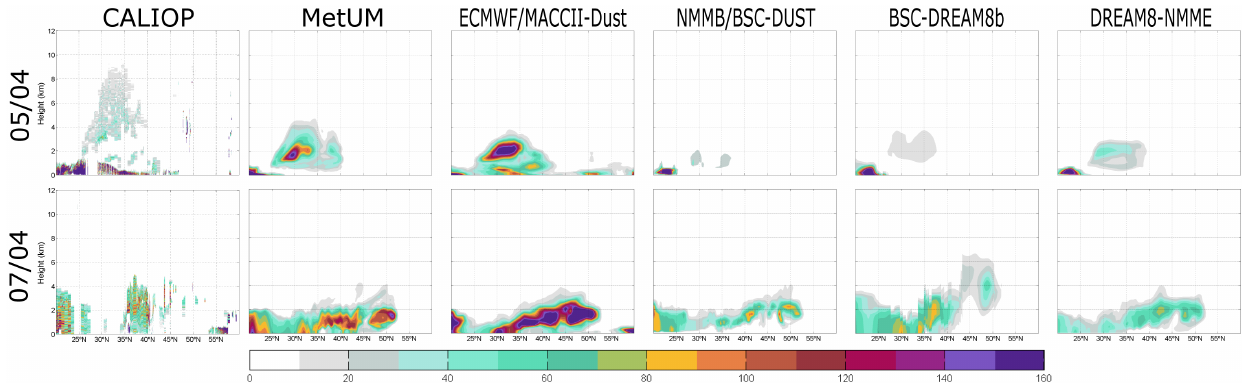
Figure 7. Profiles of measured total extinction coefficient at 532nm from the CALIOP instrument onboard the CALIPSO satellite and 24h forecasted dust extinction coefficient profiles at 532nm from models MetUM, ECMWF/MACC, NMMB/BSC-DUST, BSC-DREAM8b and DREAM8-NMME. Conditions are presented for 5 April (upper row) and 7 April (lower row). Overpass of the satellite in each case is illustrated in Fig. 3. Corresponding forecasted model profiles for 48 and 72h lead times are illustrated in Figs. S10 and S11, respectively).